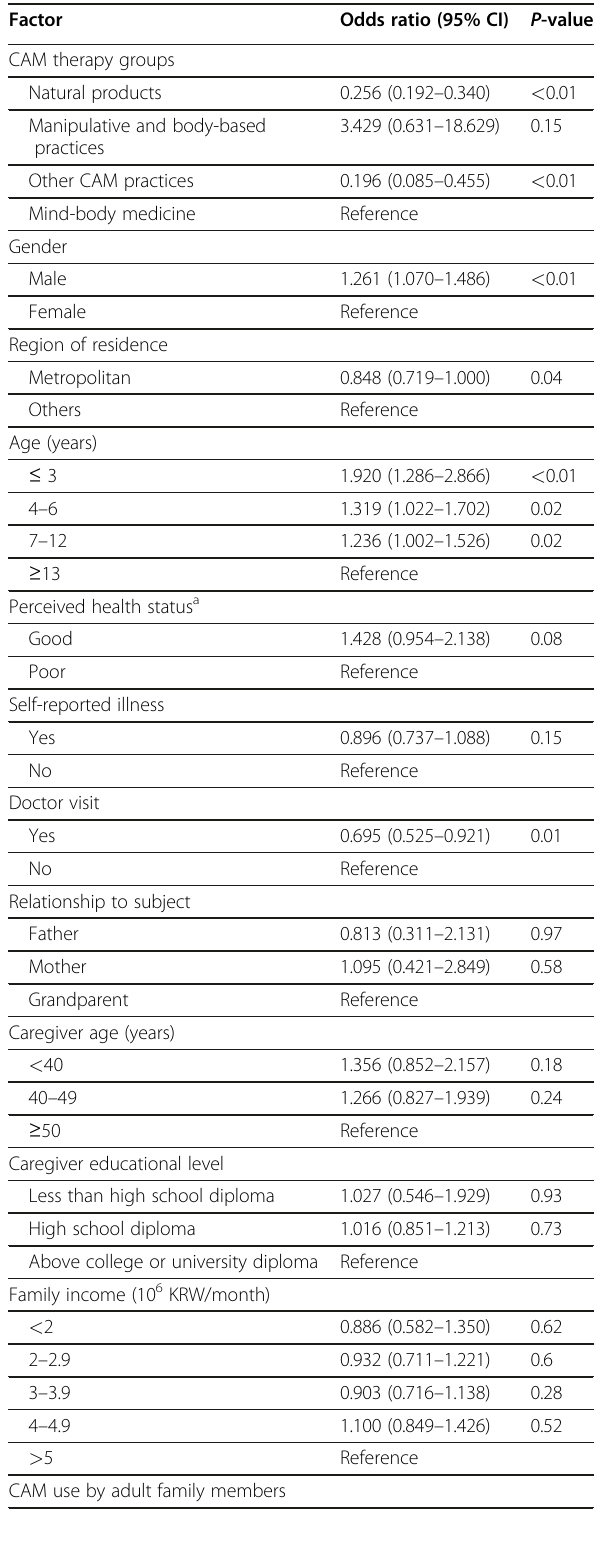
Table 3 Factors associated with satisfaction after complementary and alternative medicine (CAM) use